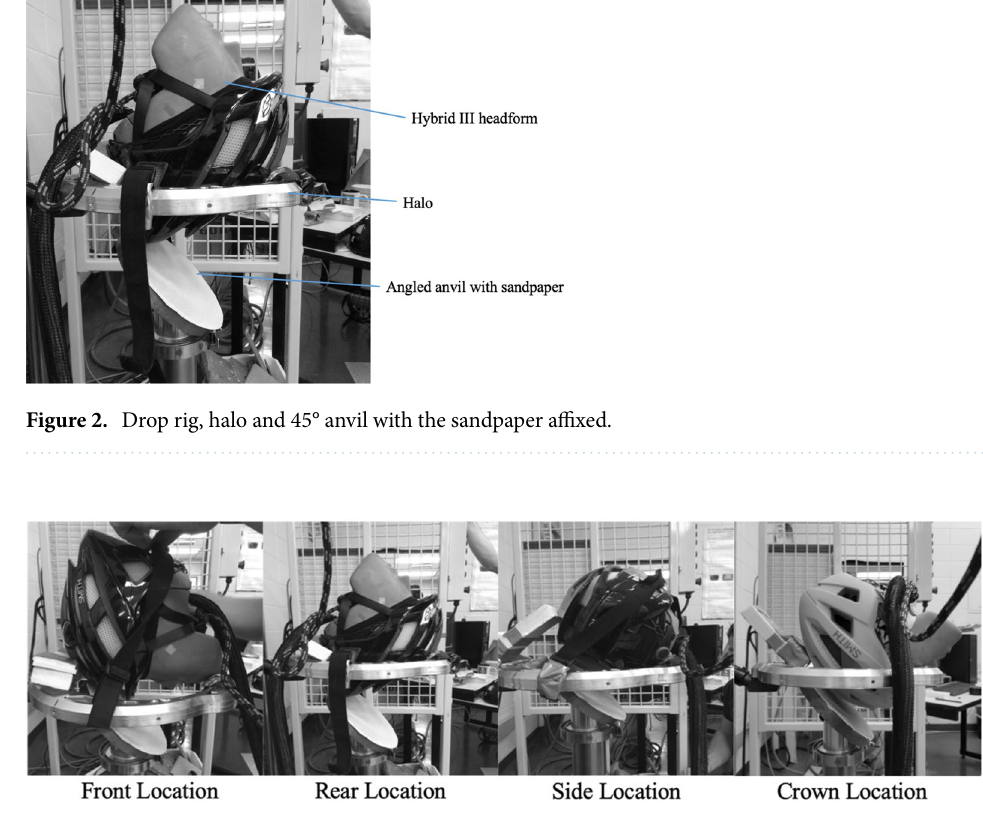
Figure 3. Headform placement for impacting the anvil in the front, rear (back), side and crown